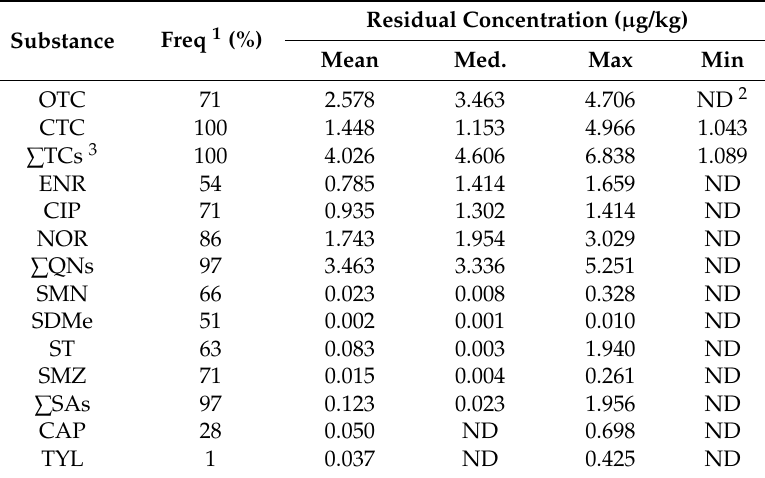
Table 4. Residues of 11 antibiotics in 35 vegetable samples ( n =